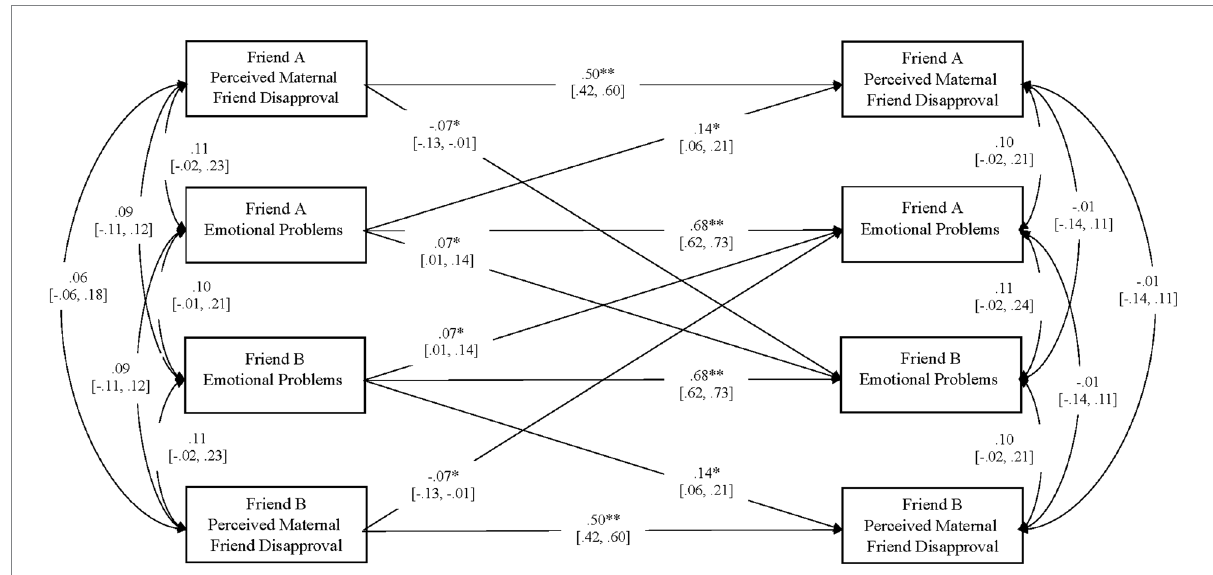
FIGURE 2 Longitudinal associations between friend internalizing symptoms and perceptions of material disapproval of friends. N = 142 dyads. For each path, 95% confidence intervals are presented in brackets. **p < 0.01,* p < 0.05,